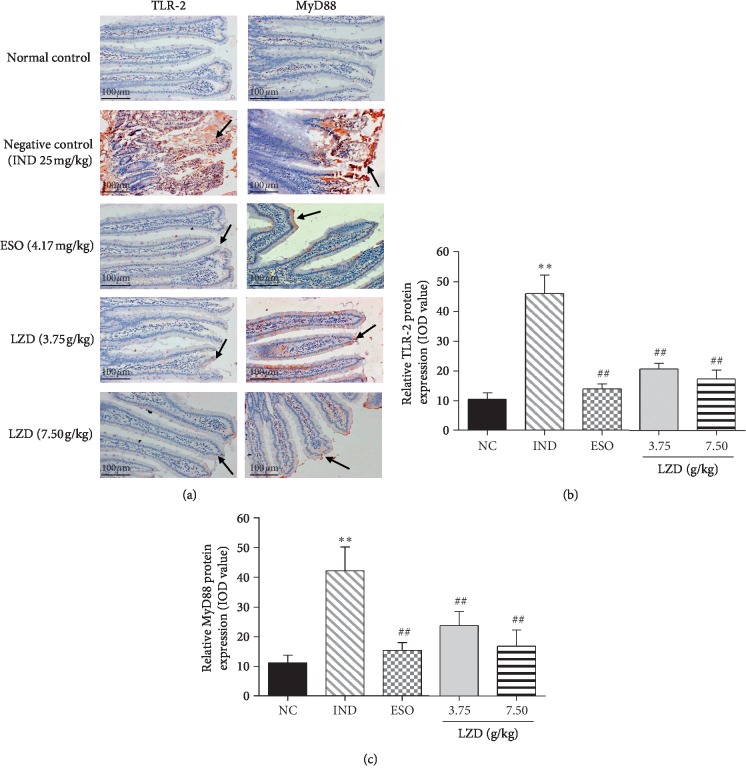
Localization of TLR-2 and MyD88 in duodenal tissues after IND administration and effect of LZD thereon. (a) Representative pictures showing the immunohistochemical analysis of TLR-2 and MyD88 in sections of duodenal mucosa obtained from rats in normal control, negative control, ESO, and LZD groups. The black arrows denote the immunopositive expression parts of TLR-2 and MyD88. Magnification 200x. (b, c) Quantitative analysis of the immunohistochemical signals as measured by IOD values. Results are expressed as the mean ± SEM (n = 3). Asterisks and pound signs indicate significant differences: ∗∗P < 0.01 versus normal control (NC); ##P < 0.01 versus negative control (IND).